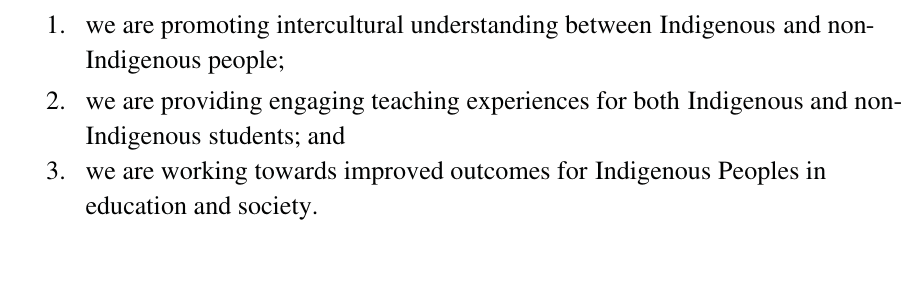
(Colour online) The collective vision statement developed by the PAR